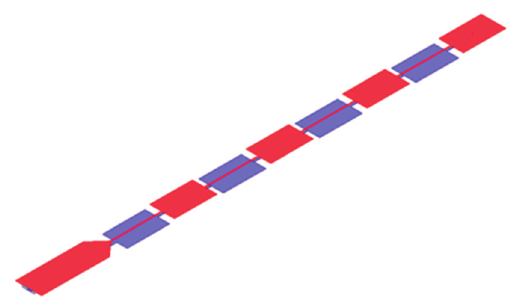
Figure 1. Proposed antenna structure.